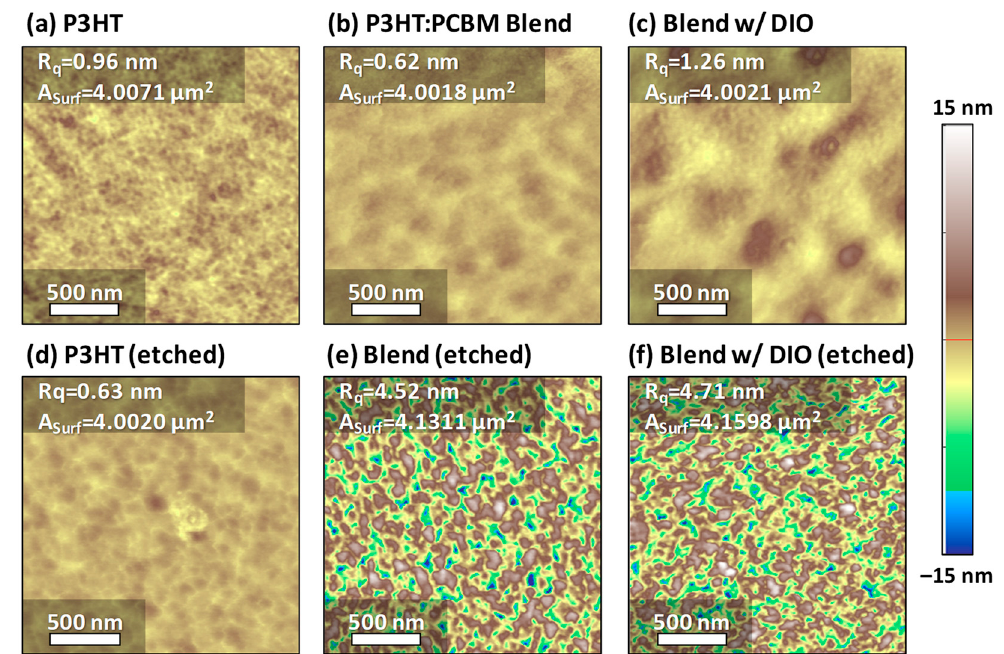
Figure 4. AFM topography images: ( a – c ) Pristine thin films of ( a ) P3HT, ( b ) P3HT:PCBM blend, and ( c ) P3HT:PCBM blend with 2.5 vol% 1,8-diiodooctane (DIO) as an additive. ( d – f ) Polymer and blend thin films after wet-etching by butyl acetate (BA). Note that the height difference is larger in ( e ) and ( f ). Polymer and blend films were cast from a solution in chloroform. The images share an identical scale bars.